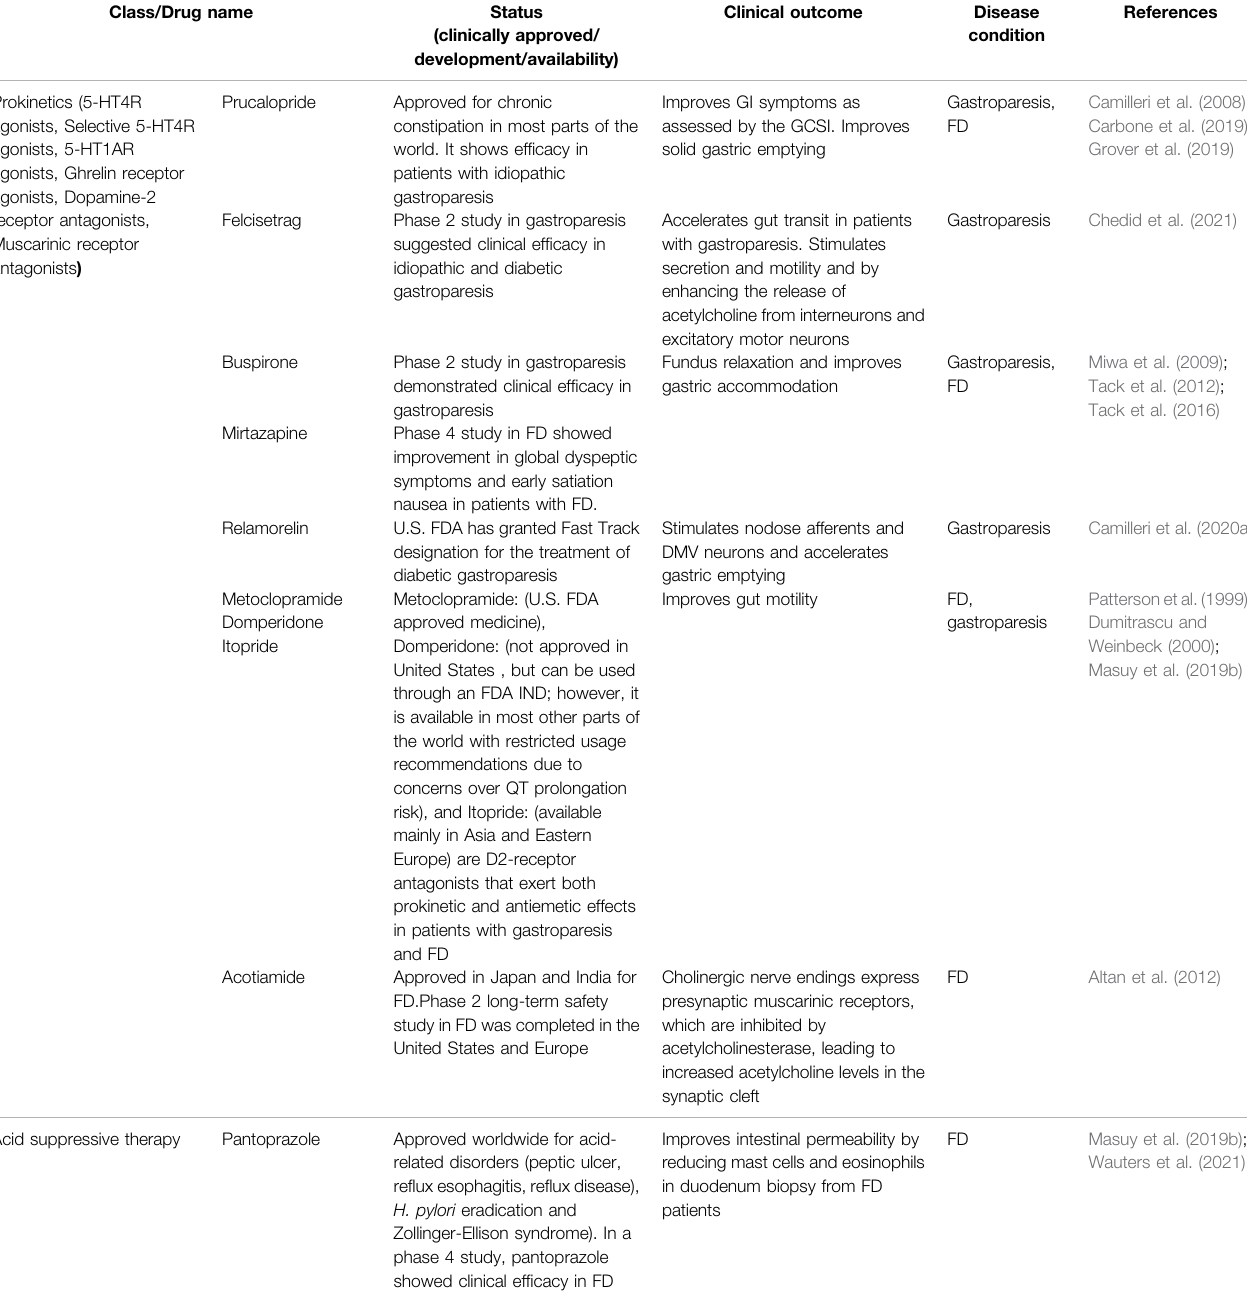
TABLE 2 | Currently available pharmacological agents for gastroduodenal motility